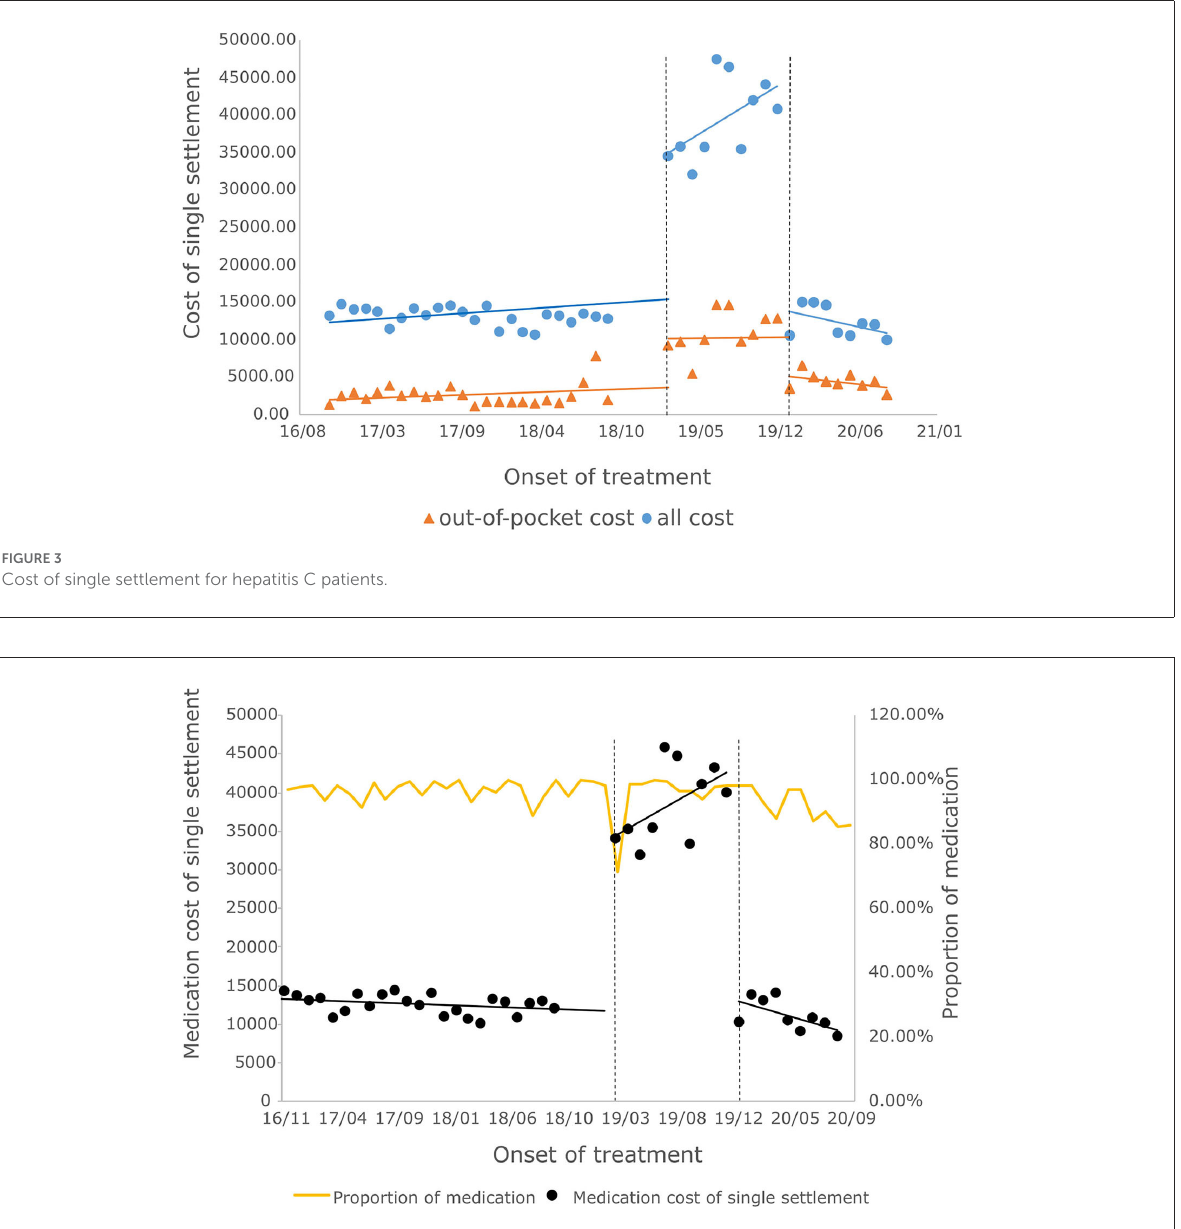
FIGURE4 Medication cost of single settlement for hepatitis C